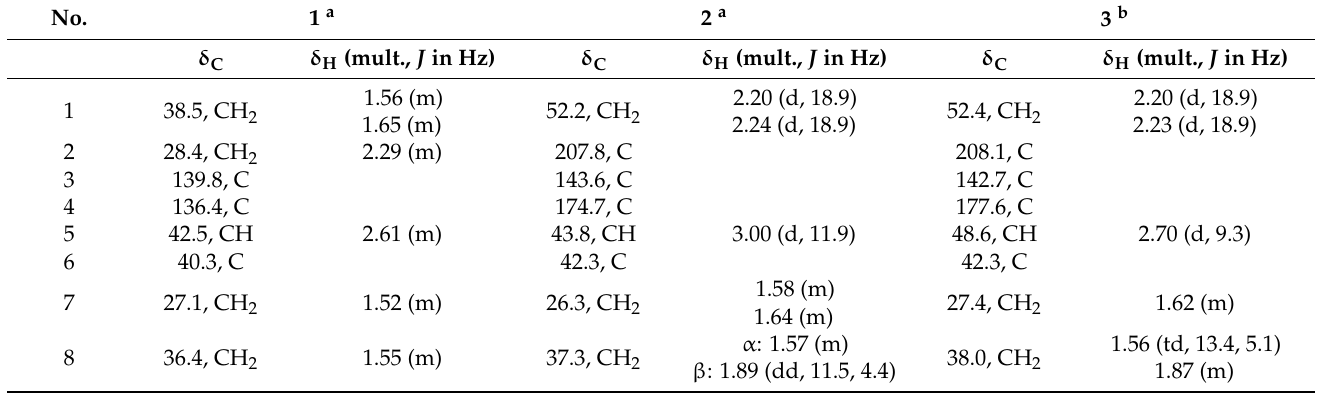
Figure 1. Structures of dentifragilins A – H ( 1 – 8 ) and of the known compounds striatal D ( 9 ) and laxitextine A ( 10 ), all isolated from submerged cultures of D. fragilis . Table 1. 1D and 2D NMR spectroscopic data of compounds 1 – 3